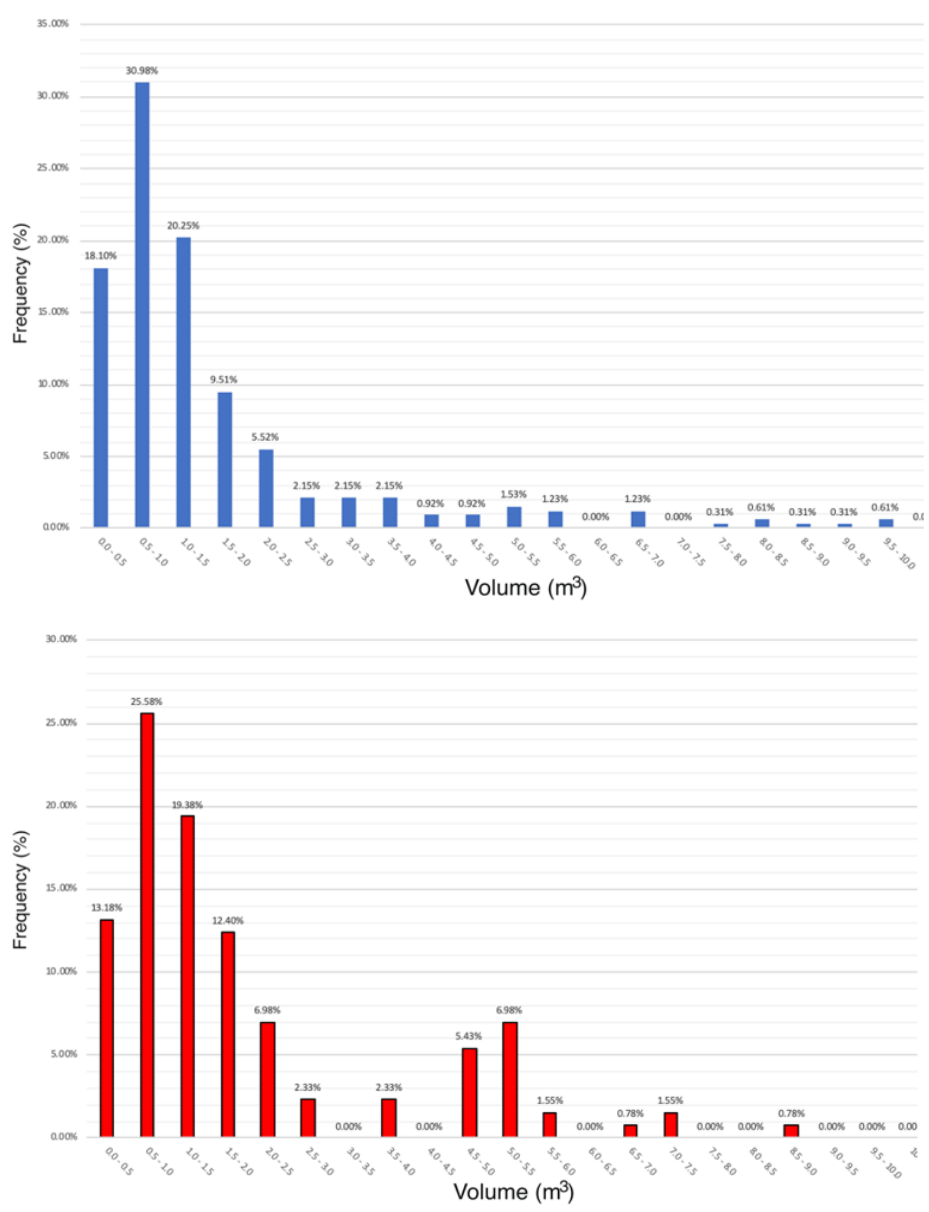
Figure 19. Volume distribution for both the fallen (blue) and the potentially unstable (red) blocks for the whole slope.